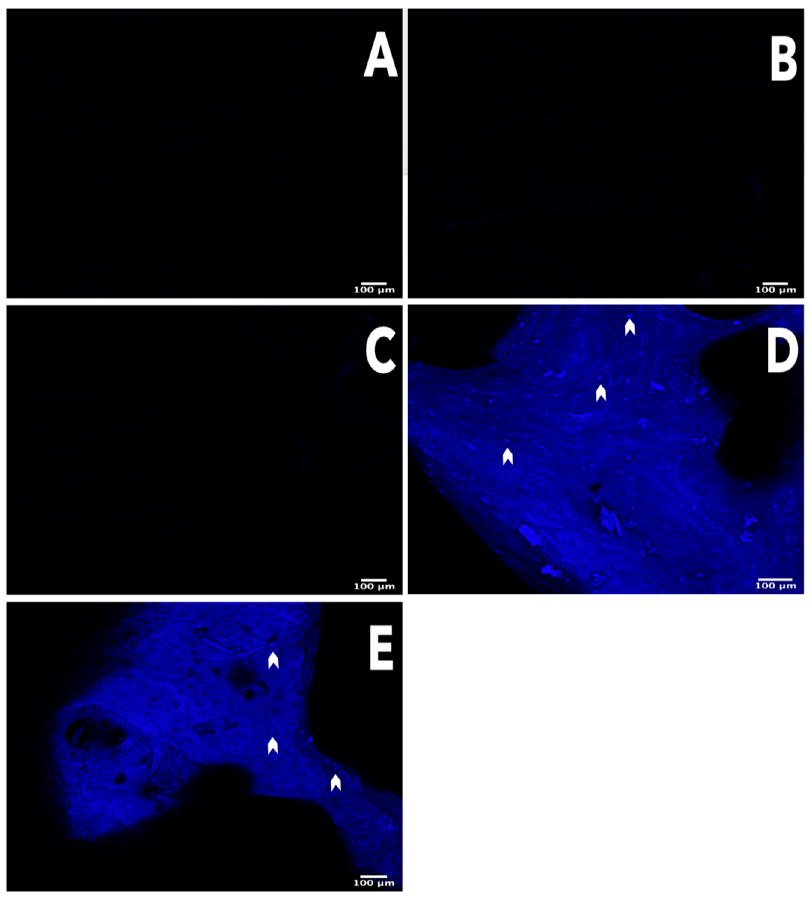
Figure 1. Confirmation of the decellularization process. Nuclear content was tested with 4 (cid:48) ,6- diamidino-2-phenylindole (DAPI) staining. Confocal microscope photomicrographs of histologically stained sections with DAPI. Bright spots (white arrowheads) indicating nuclei can be seen before decellularization ( D ) and in commercial scaffolds ( E ) Nuclei are totally absent after decellularization in 0.125 M ( A ), 0.25 M ( B ), and 0.5 M ( C ) scaffolds. 40 × scale bar = 100 µ